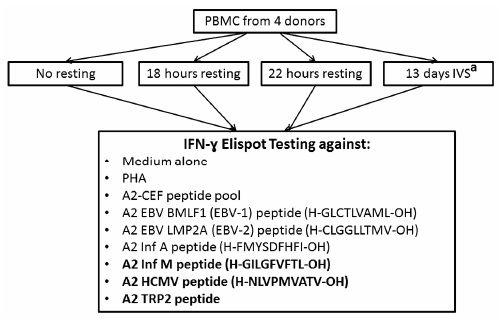
Figure 1. Summary of the experimental conditions used in the study. IVS, in vitro stimulation; PHA, phytohemagglutinin; CEF, Cytomegalie, Epstein Barr, and Influenza